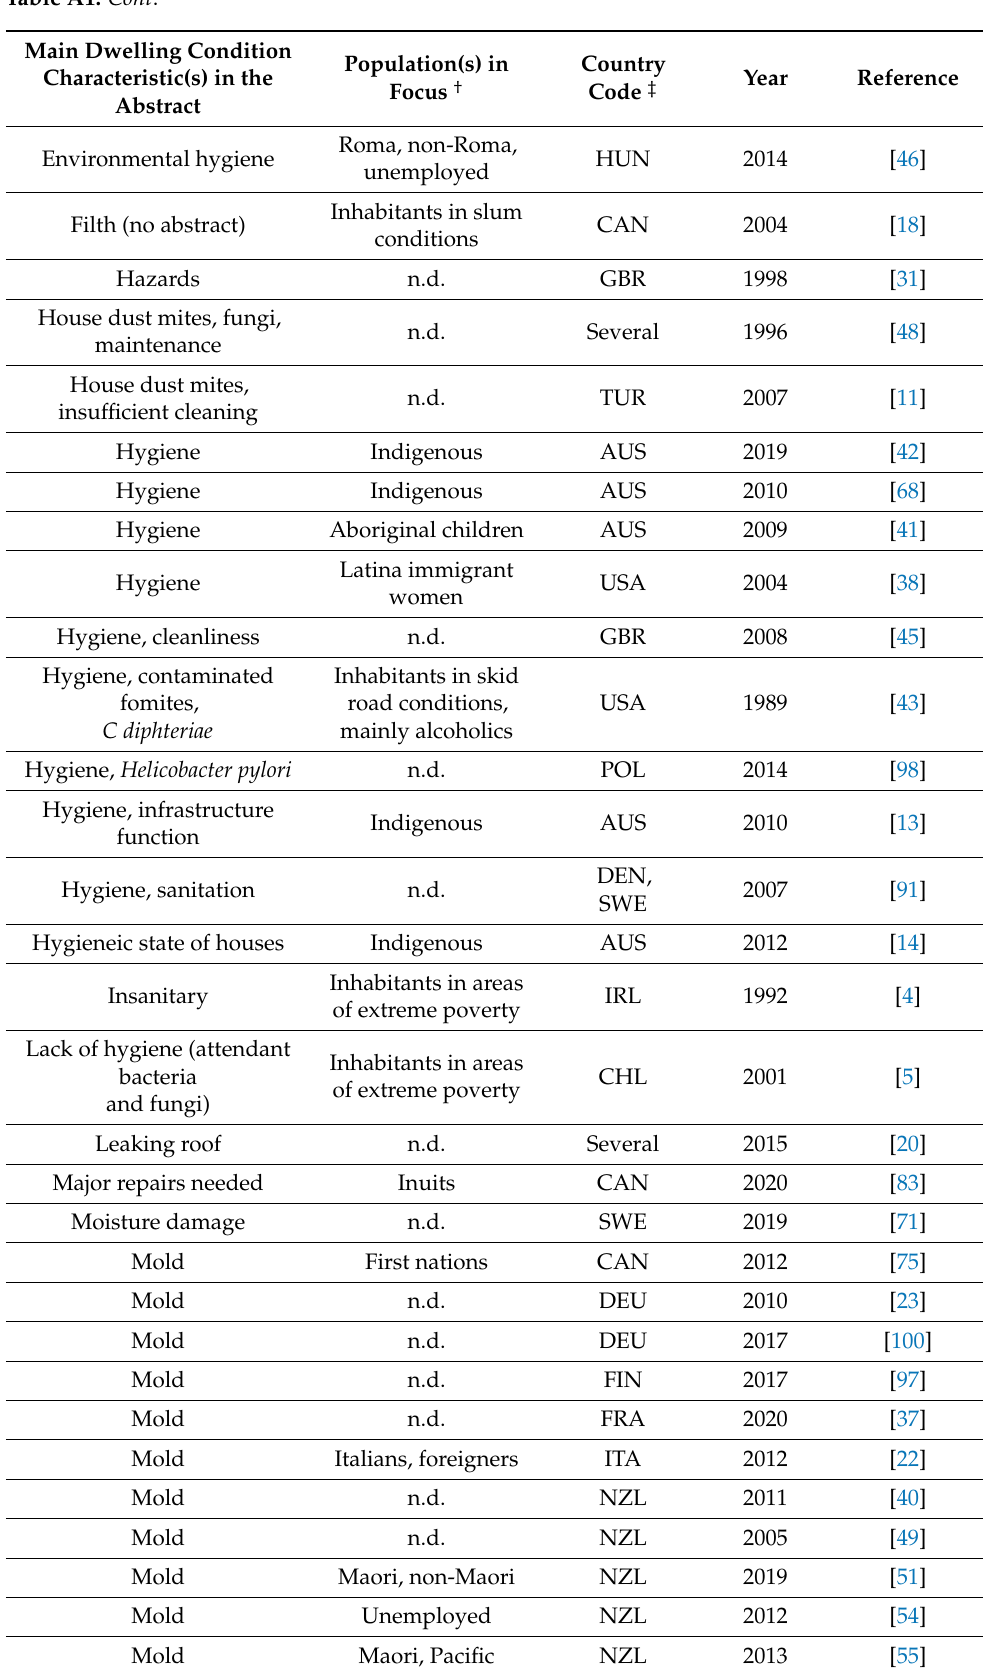
Table A1. Cont . Main Dwelling Condition Characteristic(s) in